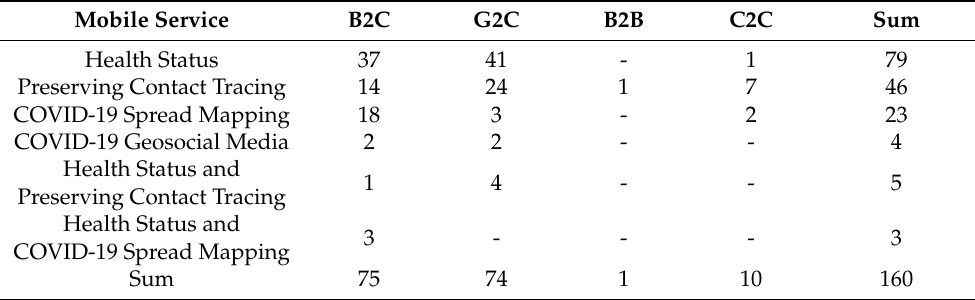
Table 4. Targeting of LBMAs.